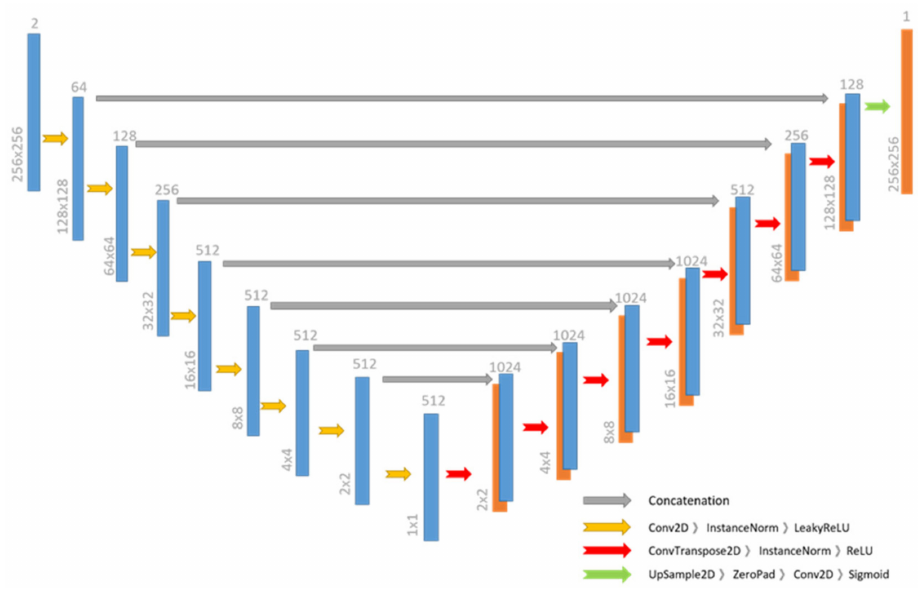
Figure 3. The generator architecture in the proposed